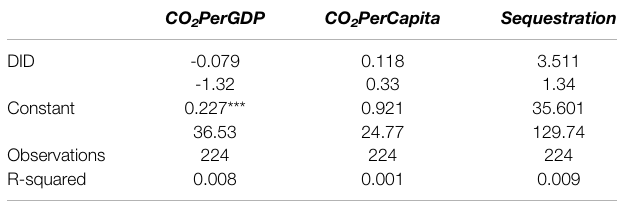
TABLE 7 | Counterfactual results for Baotou City.